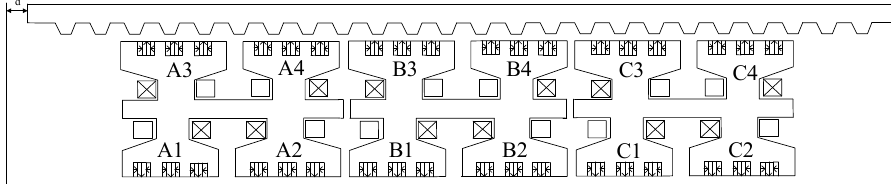
Table 1. Generator performance at different stagger angles.